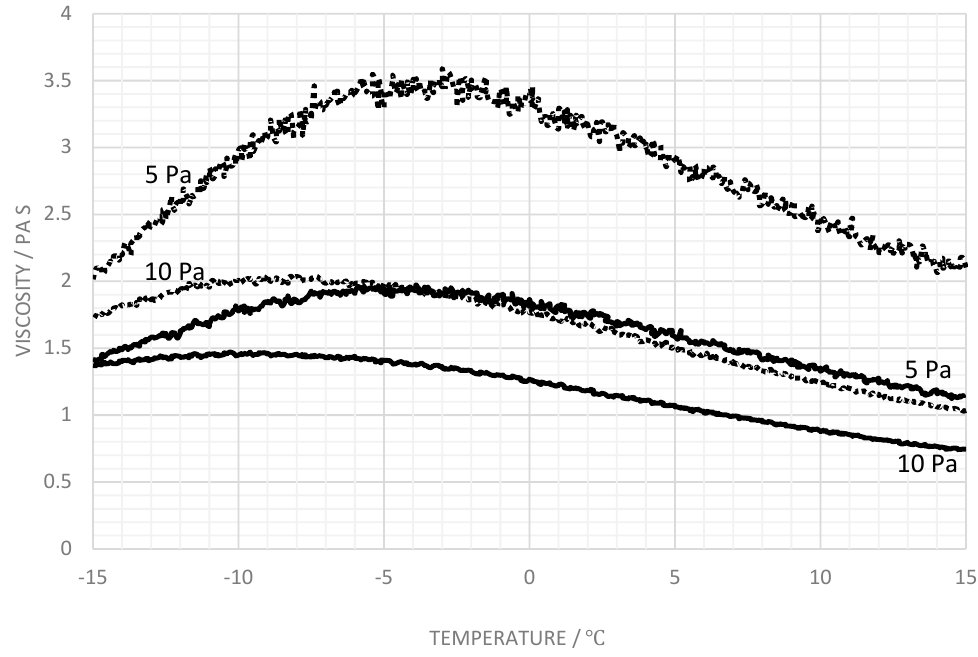
Figure 6. Viscosity variation for Carbomer A with 0.03 wt% of K + ( ‒ ) (A1K) and 0.03 wt% of Na + ( ∙∙∙ ) (A1N) at shear stresses of 5 and 10 Pa.